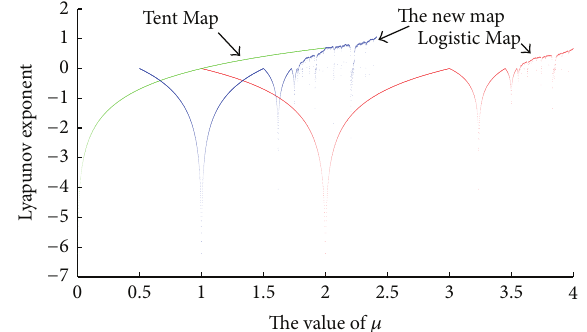
Figure 5: Lyapunov exponent spectrum comparison with three chaotic